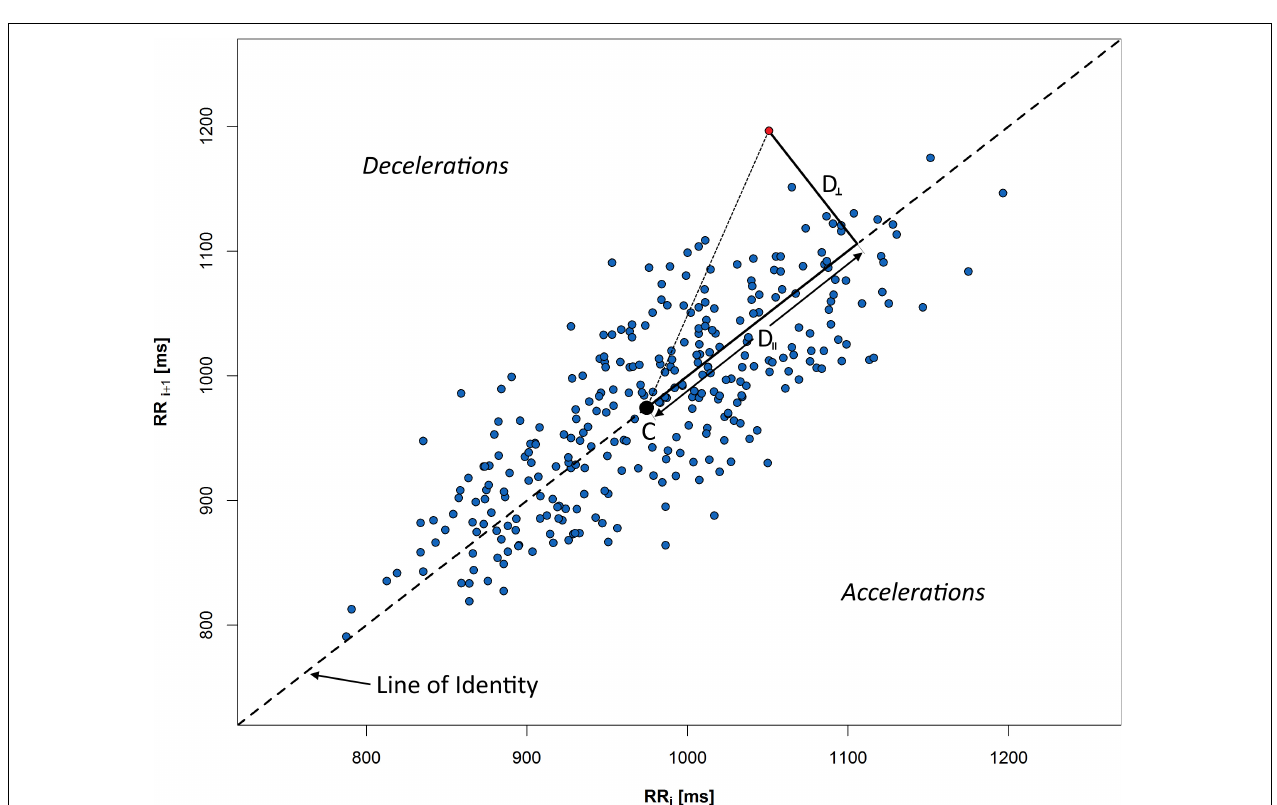
FIGURE 2 | Poincaré plot of 5 min RR sequence recorded during rest in supine. Distances from selected red point to the centroid C are measured along the LI (D (cid:107) ), and perpendicular to the LI (D ⊥ ). All points above LI respond to the decelerations of human heart rate, whereas points under the line indicate accelerations (consecutive shortening of RR time